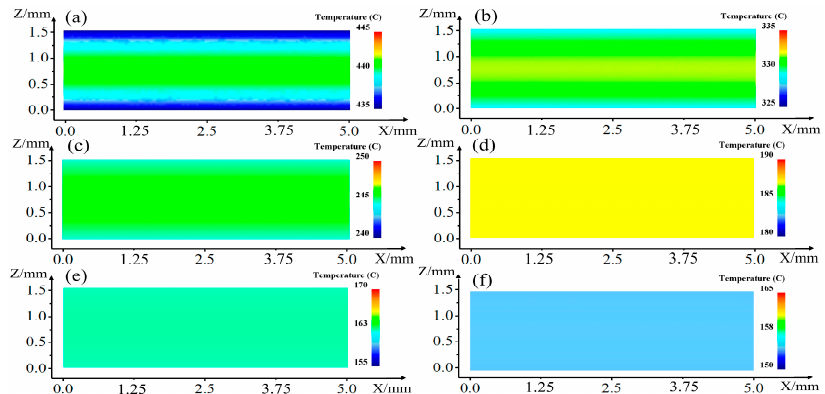
Figure 3. Temperature distribution under different quenching time: ( a ) 3 s, ( b ) 6 s, ( c ) 9 s, ( d ) 12 s, ( e ) 15 s and ( f ) 18 s.